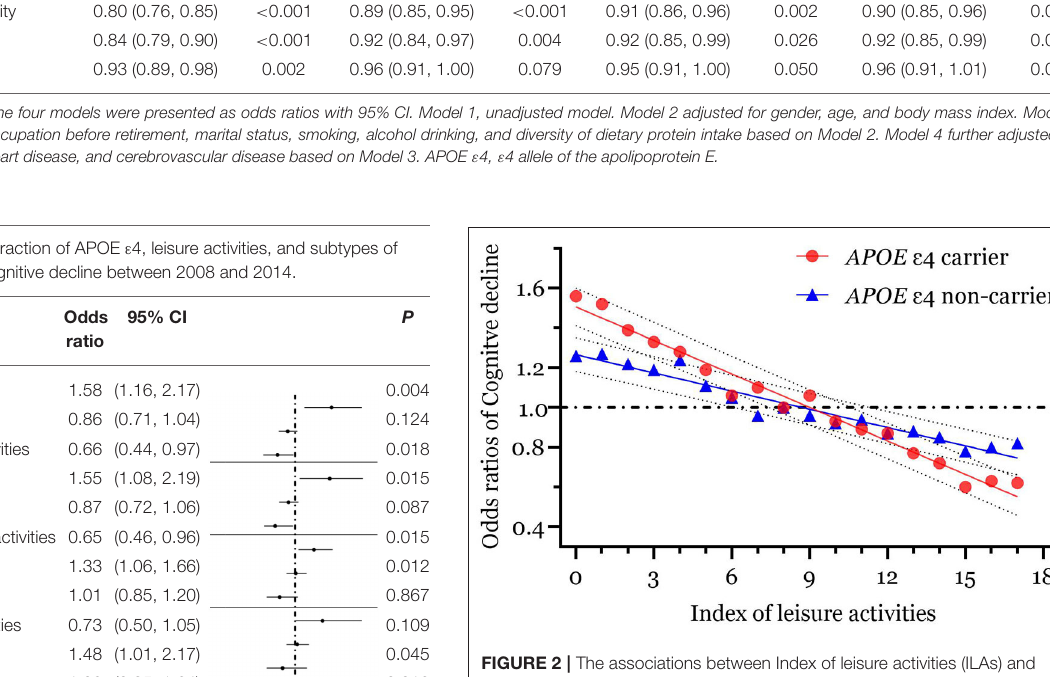
FIGURE 2 | The associations between Index of leisure activities (ILAs) and cognitive decline by the status of possessing APOE ε 4 allele. APOE ε 4, ε 4 allele of the apolipoprotein